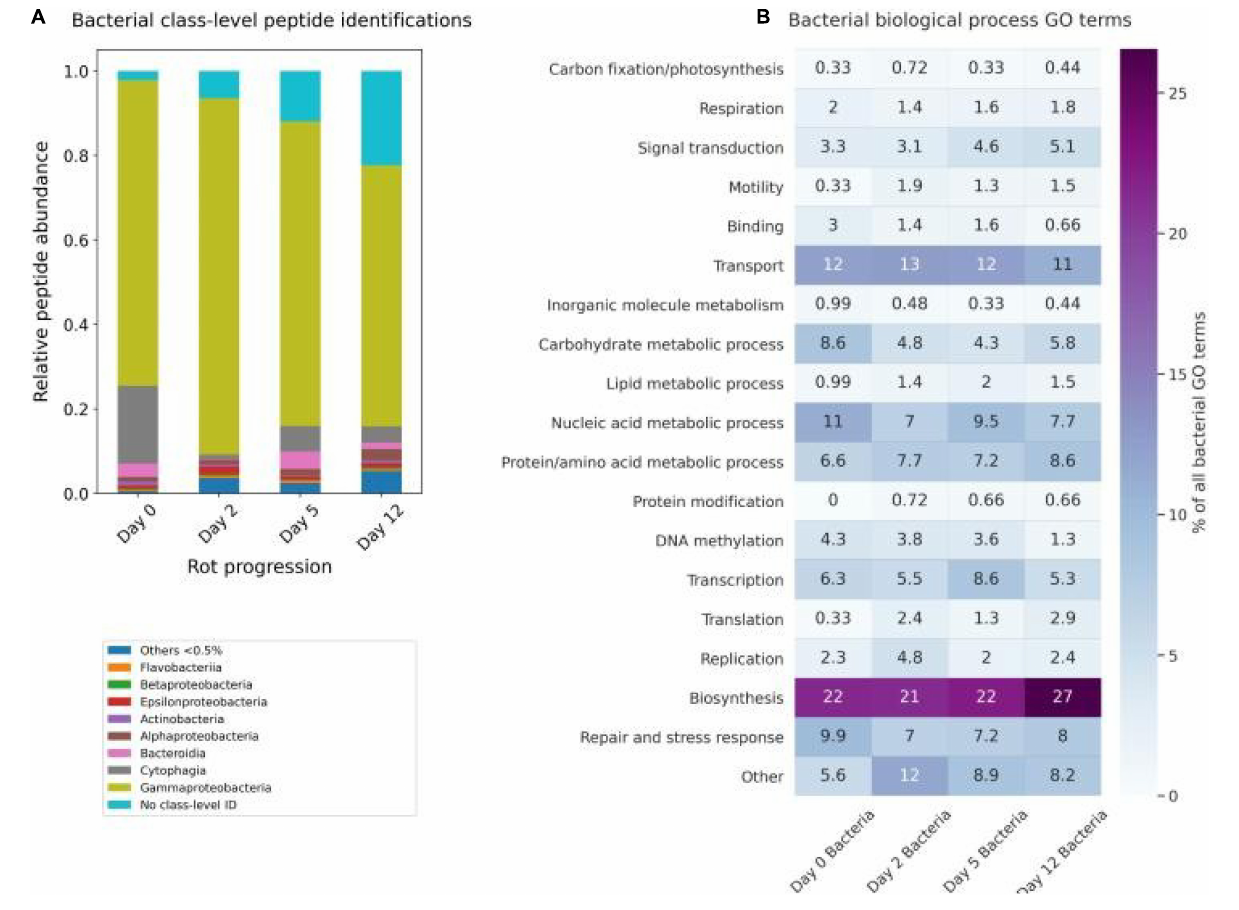
data and paired GO term data are not as complete, but